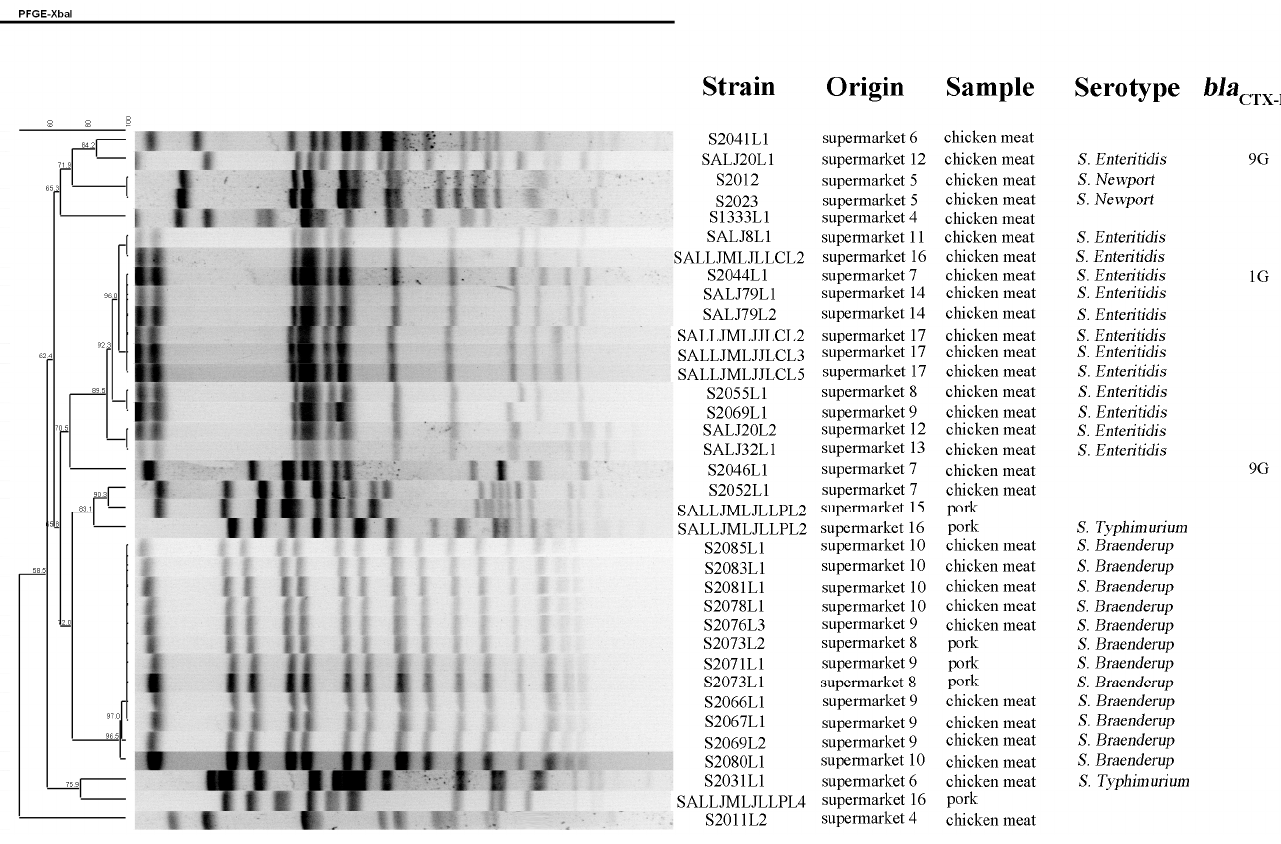
Figure 1. Characteristics and PFGE dendrogram patterns of the 36 Salmonella isolates from retail meats of different origins.